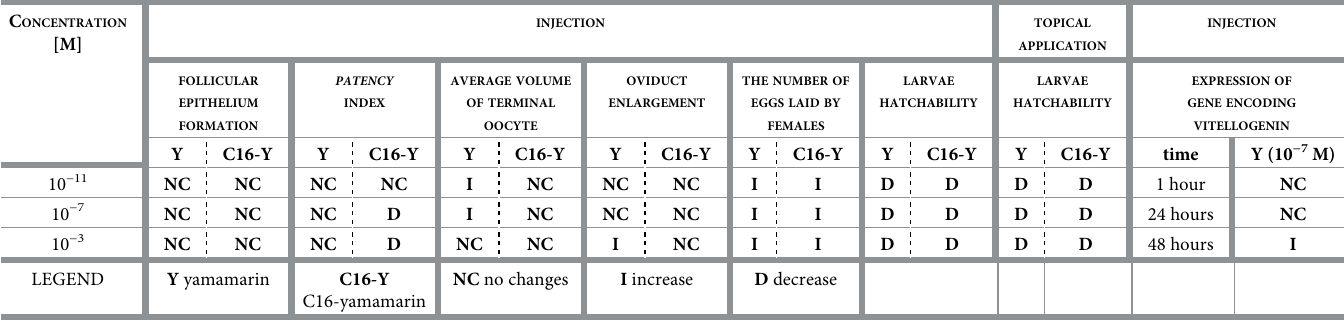
Table 2. Summary of the effects caused by yamamarin and palmitic acid-conjugated yamamarin. C ONCENTRATION